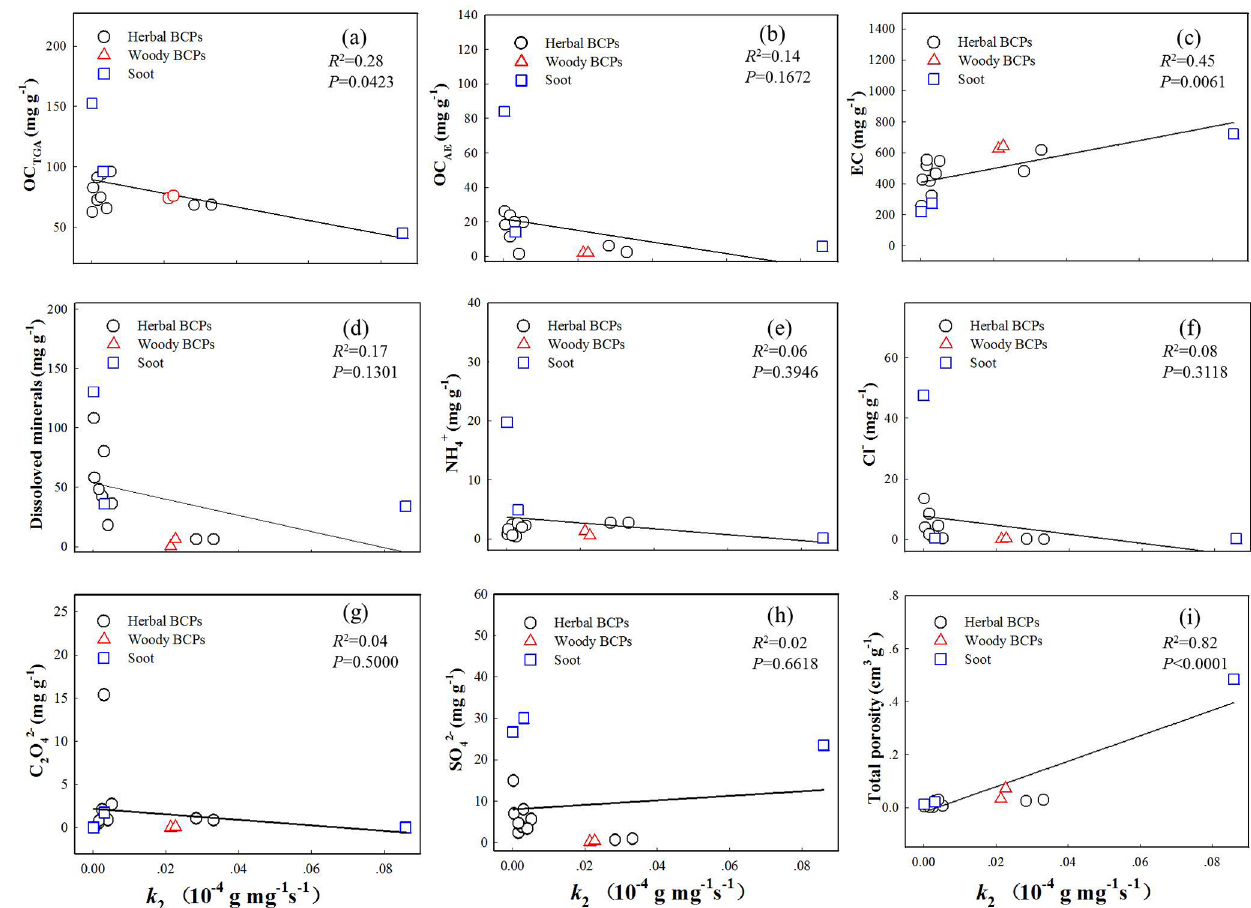
Figure 5. Relationships between pseudo-second-order water uptake rate constant ( k 2 ) (gmg − 1 s − 1 ) vs. compositional and pore property parameters for the group of BCPs at 94% relative humidity. (a) TGA-measured organic carbon (OC TGA ) . (b) Alkali-extracted organic carbon (OC AE ) . (c) Elemental carbon (EC). (d) Dissolved minerals. (e) Ammonium (NH + Sulfate (SO 2 − ). (i) Total 4